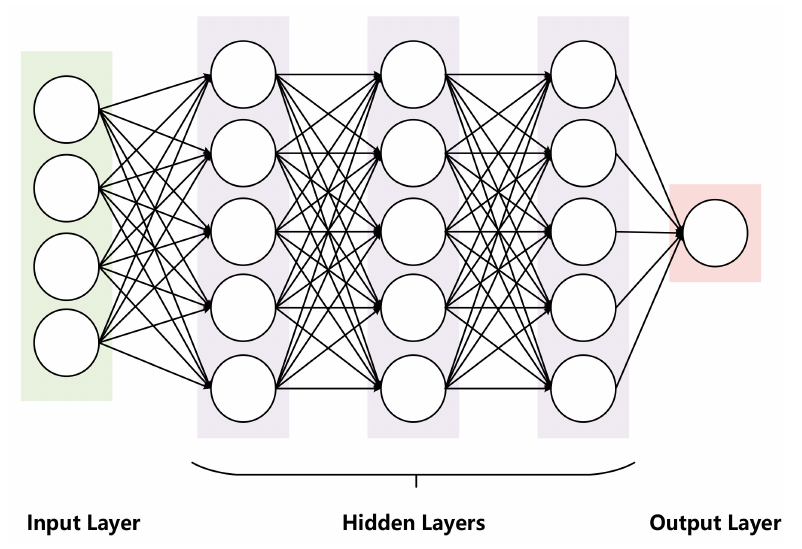
Figure 2. Fully Connected Neural Network Structure.